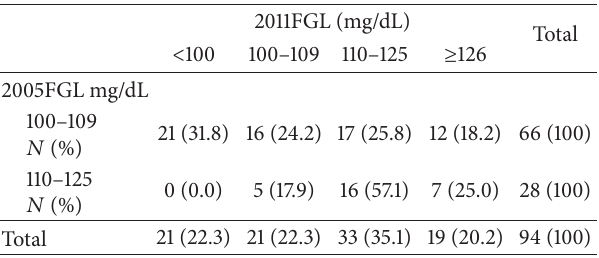
Table 2: Comparison between diabetics and no diabetics according to gender and family history of T2DM in first relative